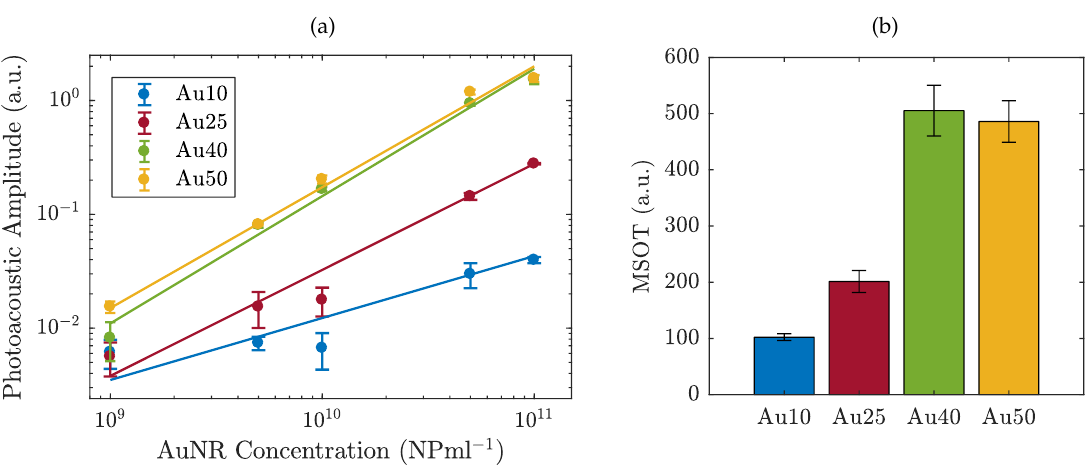
Figure 1. The photoacoustic amplitude of four different sized AuNRs ( a ) as a function of concentration from 1 × 10 9 − 1 × 10 11 NP/mL as measured with a 1MHz probe, and ( b ) at a fixed concentration of 1 × 10 11 NP/mL, measured using a pre-clinical multispectral optoacoustic tomographic (MSOT)